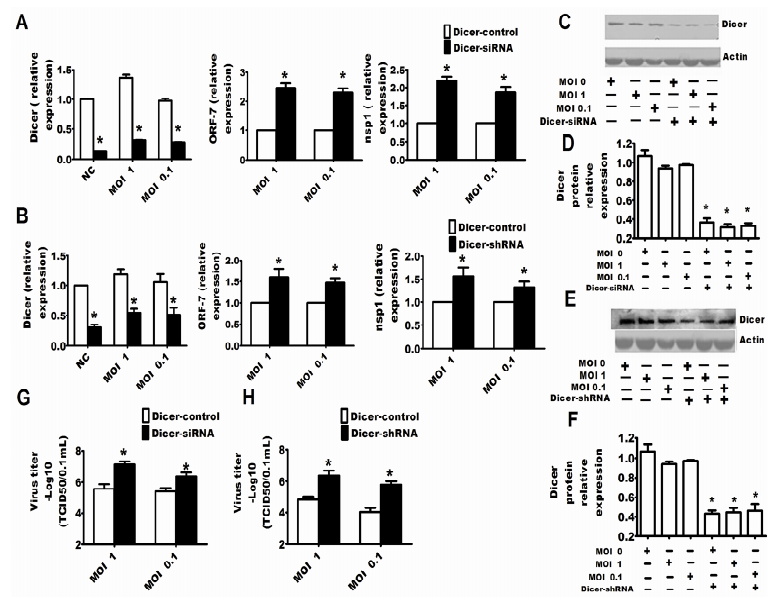
Figure 2. Dicer was involved in protection against the replication of PRRSV in MARC-145 cells. MARC-145 cells were transfected with Dicer-siRNA ( A ) or Dicer-shRNA ( B ). After 24 hours, the cells were infected with PRRSV at an MOI of one or 0.1. Additionally, 24 h after PRRSV infection, cells were ready for qRT-PCR of Dicer, PRRSV ORF-7 and PRRSV nsp1 ( A , B ) or the cells were collected for Western blots for Dicer ( C , E ). The results of Western blot for Dicer were quantified by Quantity One Software ( D , F ). The viral yields in the supernatants were quantified by a 50% tissue culture infective dose (TCID 50 ) ( G , H ). The experiments were repeated three times. The results are from one of three independent experiments with similar observations. * p < 0.05.